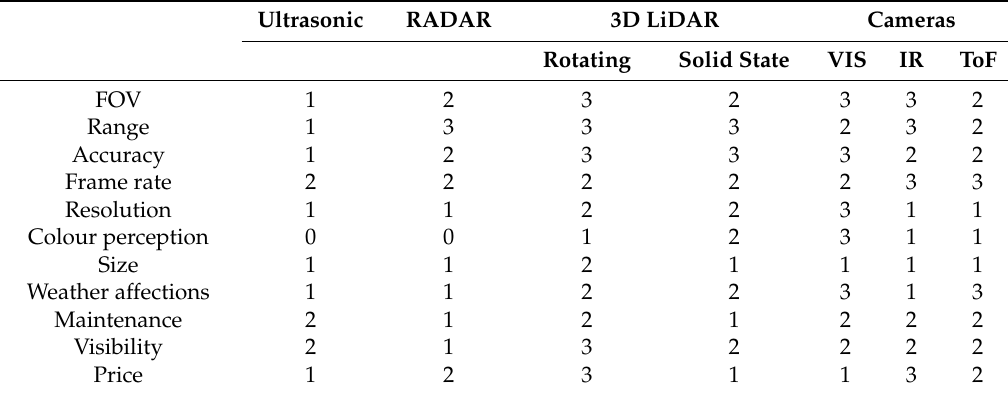
Table 1. Summary of the main features of sensors used in perception systems of